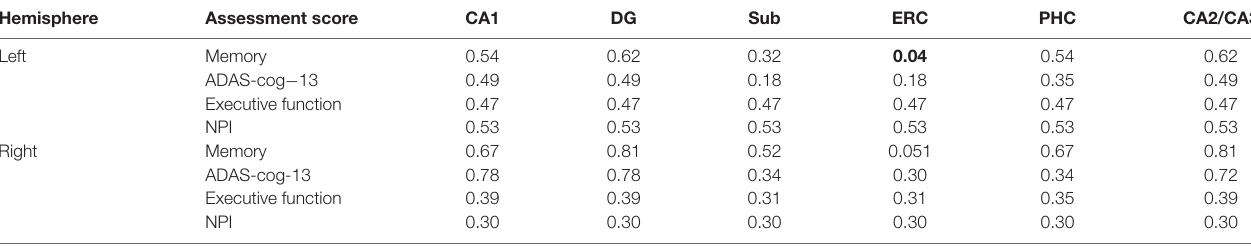
Bold values mean the p’s < 0.05 and statistically significant. TABLE 4 | Associations between assessment scores and volume of the hippocampal subfields for A − group ( p < 0.05, FDR correction). Hemisphere Left